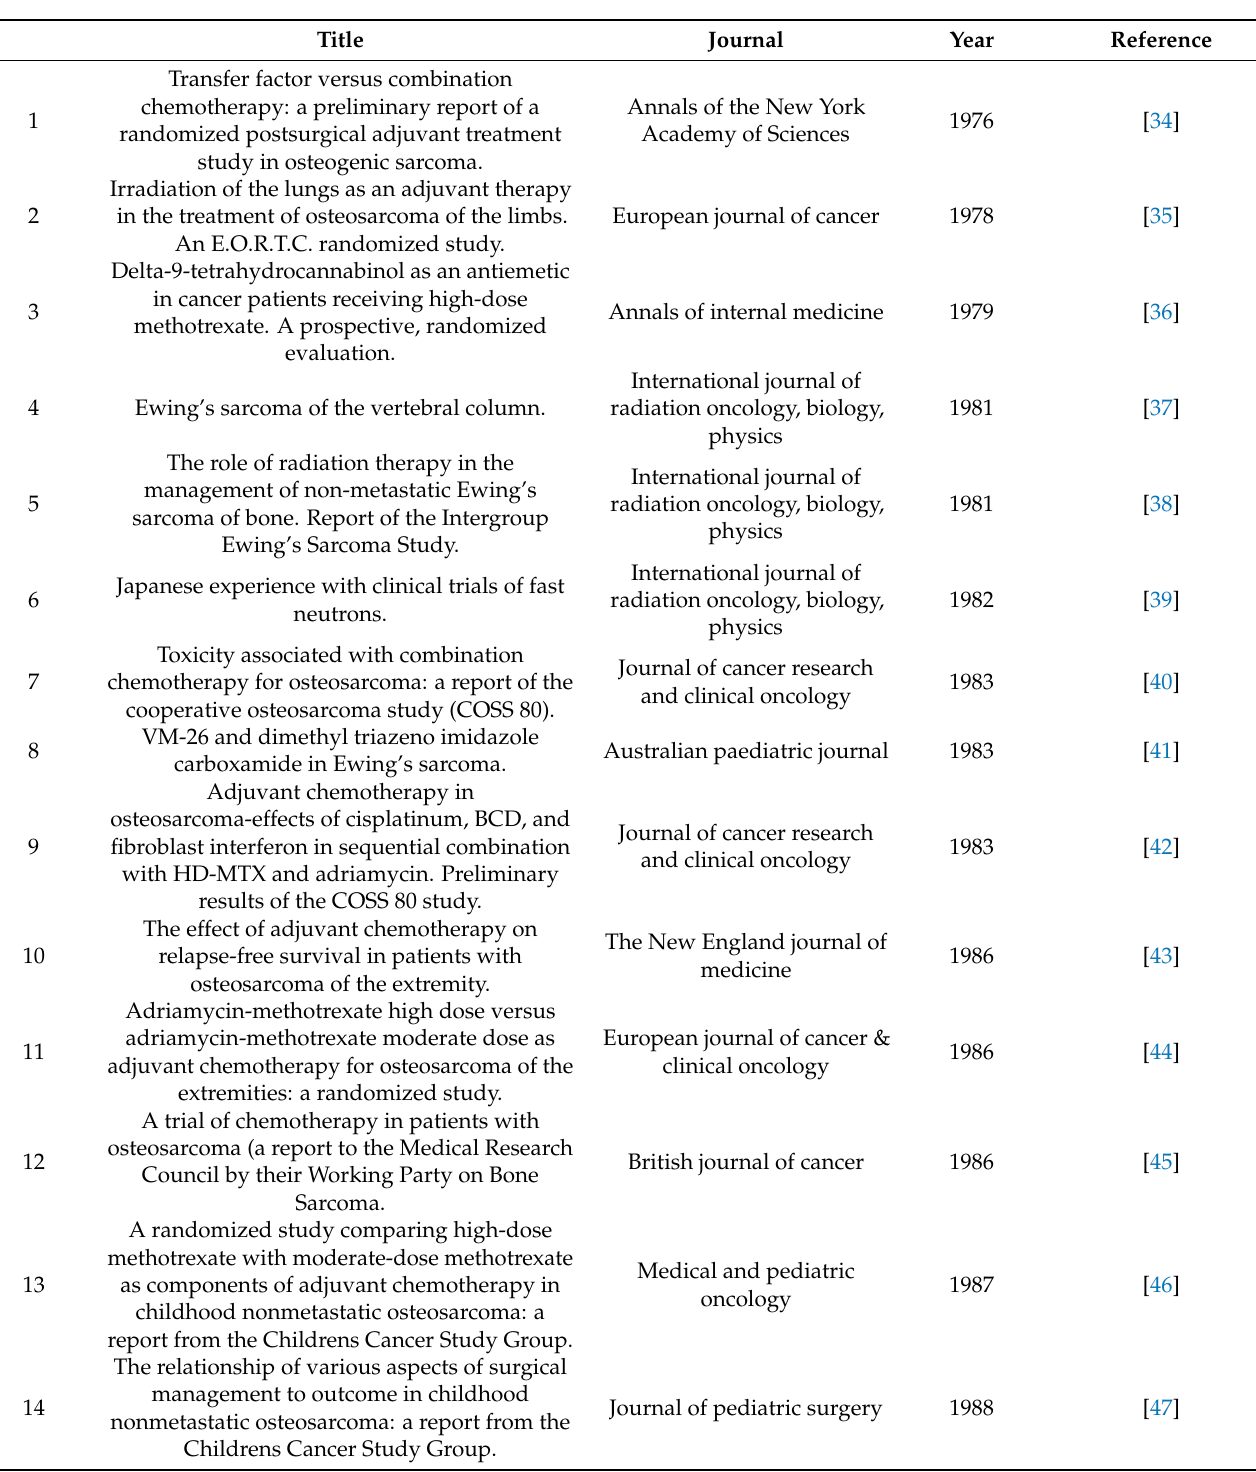
Table A1. List of included